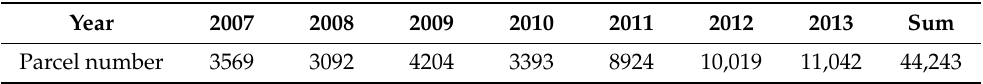
Table 1. Sample size of database after